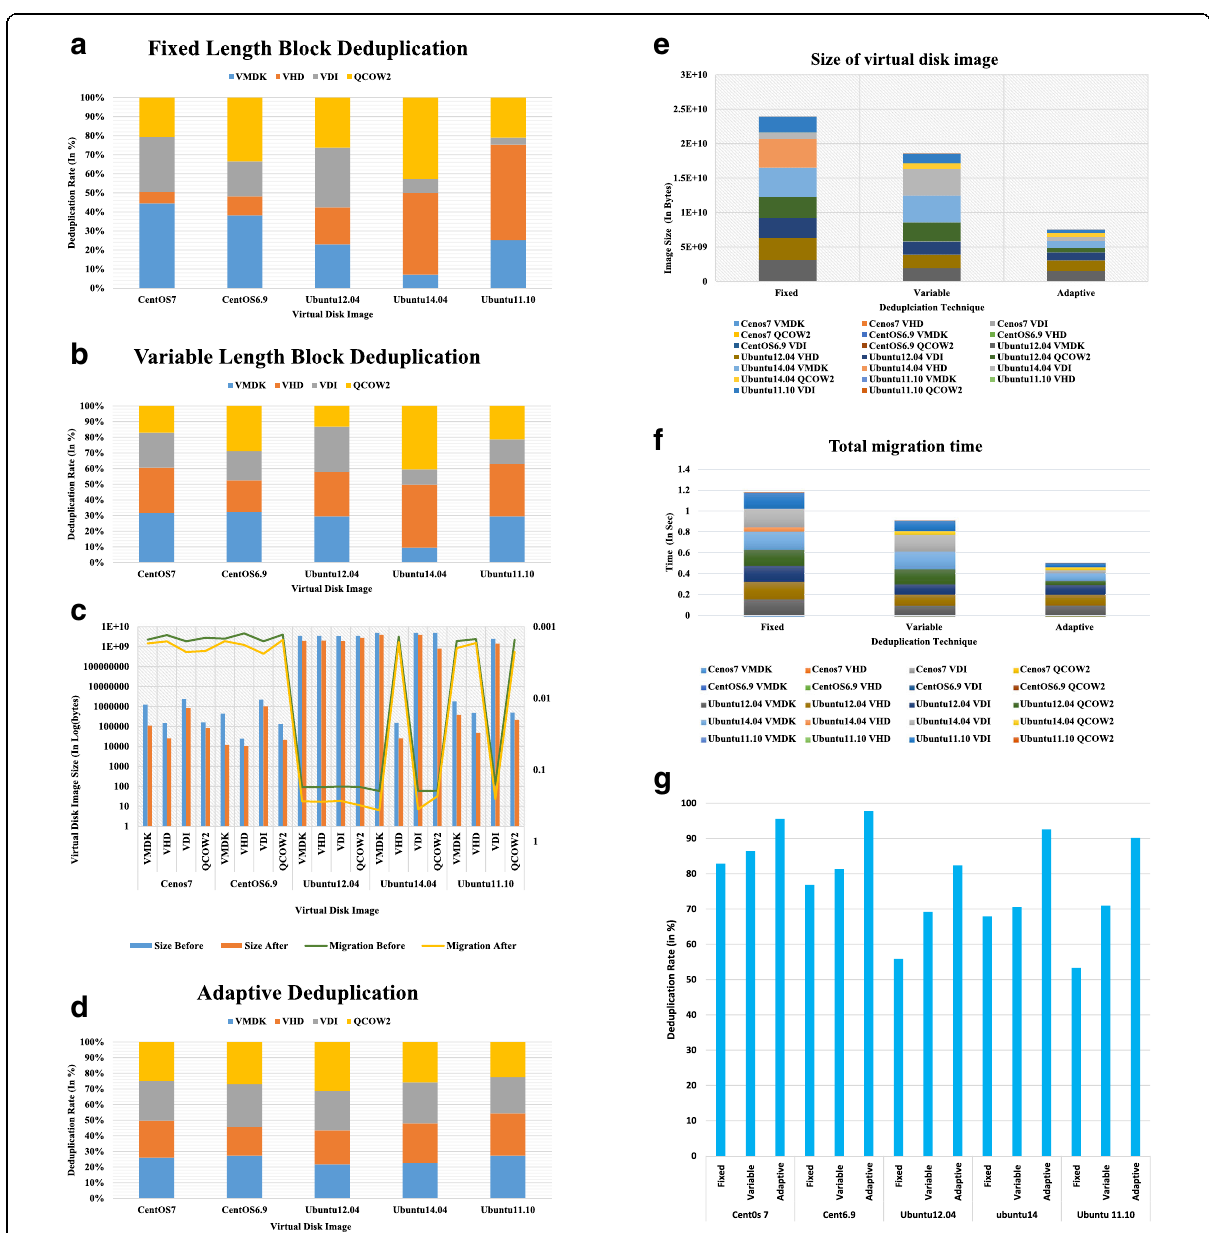
Fig. 5 a Deduplication Rate (in %) for Fixed length block deduplication. b Deduplication Rate (in %) for Variable length block deduplication. c Comparison of virtual disk image size and total migration time before and after variable length block deduplication for the image data set. d Deduplication Rate (in %) for Adaptive deduplication. e Comparison of size of disk image files after performing fixed length, variable length adaptive deduplication techniques. f Comparison of total migration time after performing fixed length, variable length adaptive deduplication techniques. g Comparison of Deduplication rate for fixed size, variable size block deduplication and adaptive